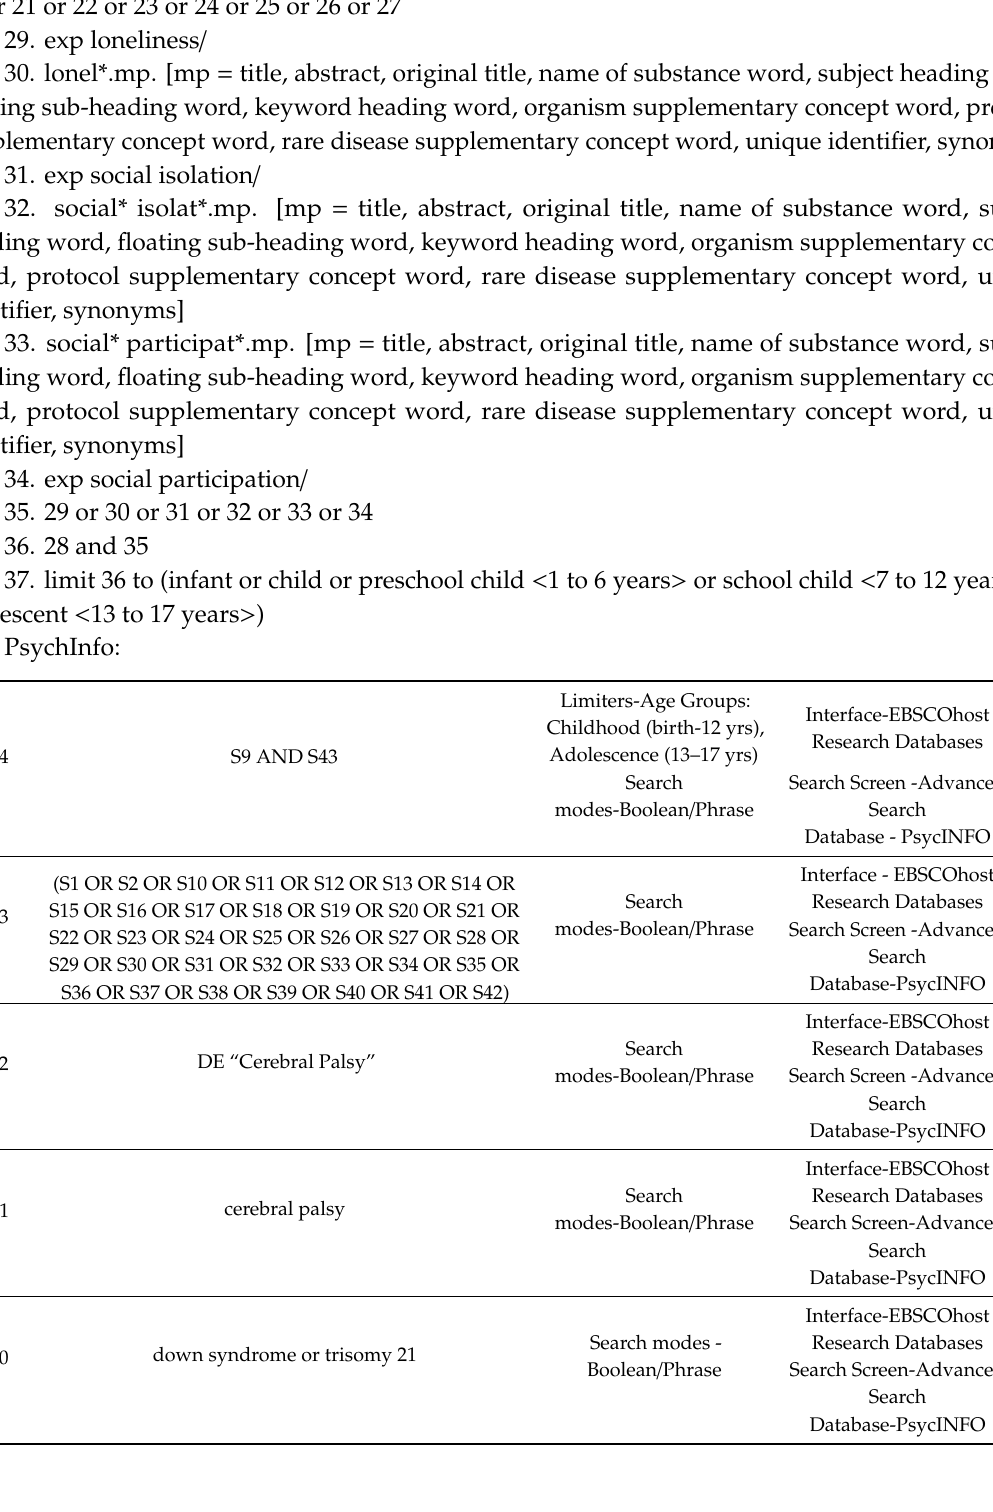
heading word, floating sub-heading word, keyword heading word, organism supplementary concept word, protocol supplementary concept word, rare disease supplementary concept word, unique